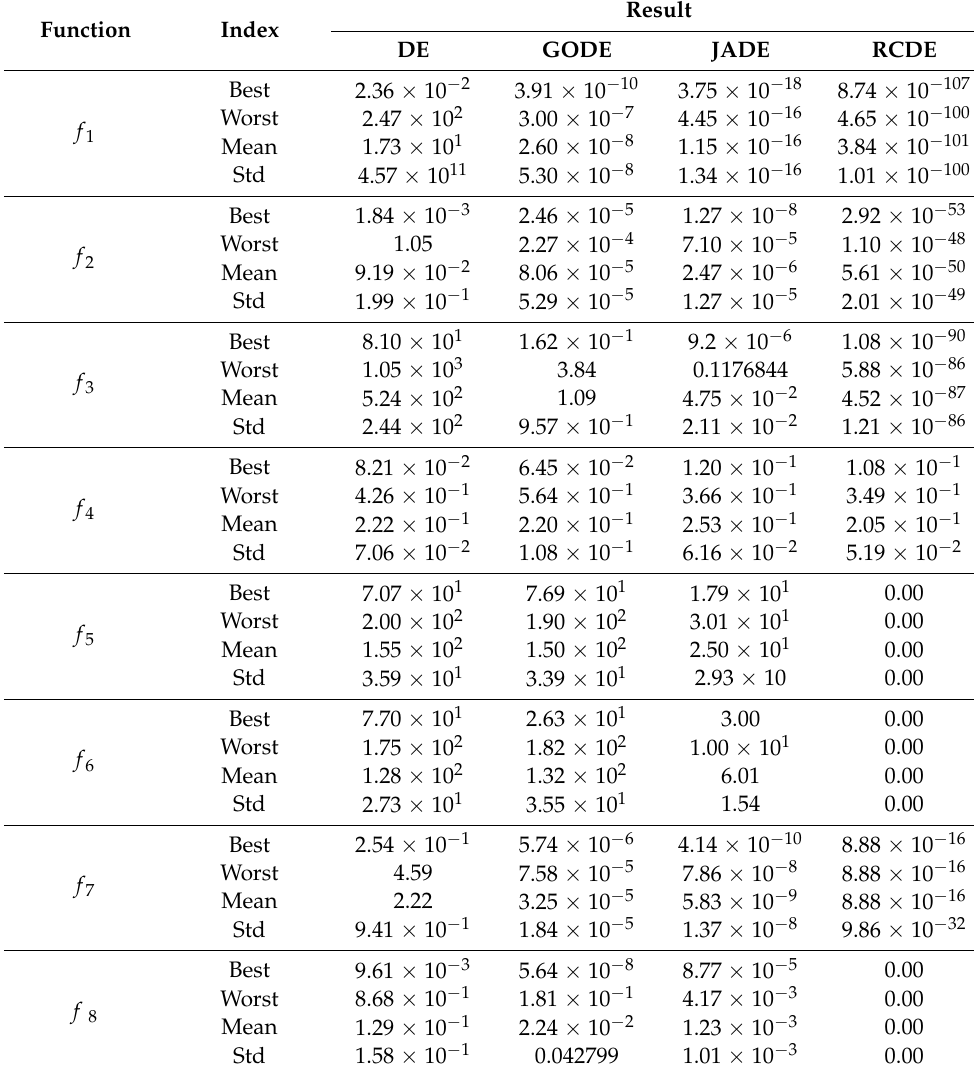
Table 4. Benchmark function experimental